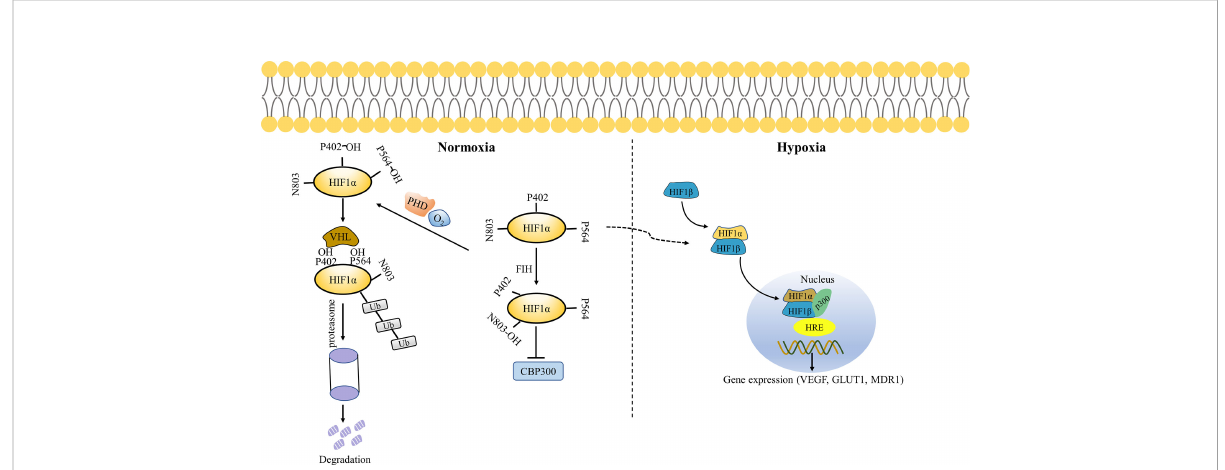
FIGURE 3 Oxygen-dependent regulation of HIF-1 a . Under normoxic conditions, FIH hydroxylates HIF-1 a Asn803 residues and blocks the binding of HIF- 1 a to CBP/P300, thereby inhibiting its transcriptional activation. PHD hydroxylates the key residues Pro564 and Pro402 of HIF-1 a , resulting in pVHL binding to HIF-1 a and ubiquitination of HIF-1 a , which is ultimately degraded by the proteasome. Under hypoxia conditions, FIH and PHD are inactivated. HIF-1 a and HIF-1 b translocate to the nucleus, thus binding to p300 and hypoxia response elements (HRE) in the nucleus to activate gene